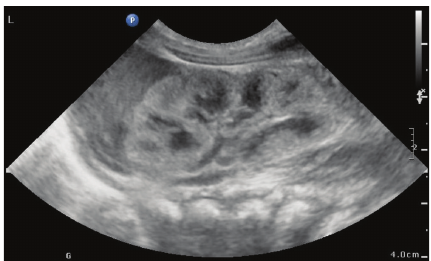
Figure 2: Normal looking left kidney in abdominal ultrasonogra- phy.